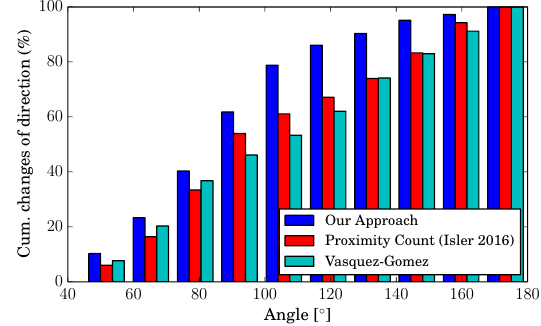
Figure 6. Global uncertainty of the map at each viewpoint.